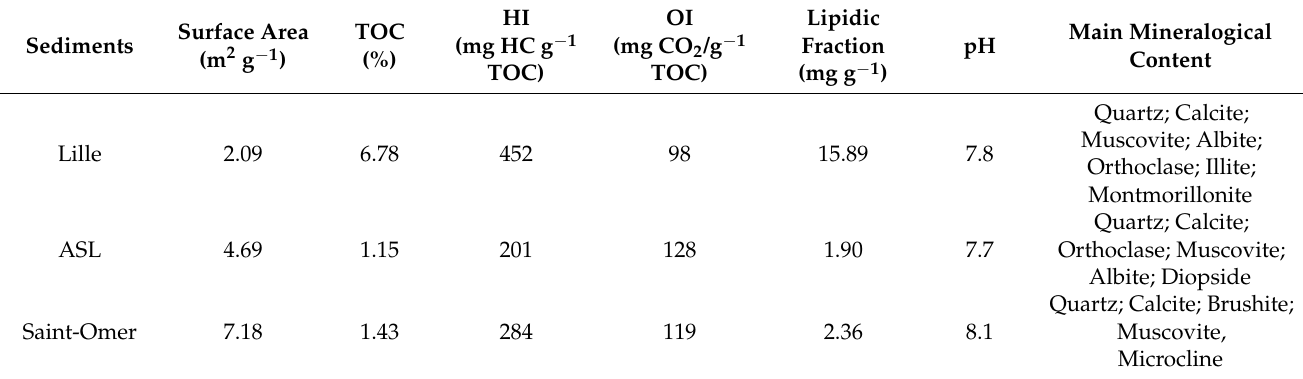
Table 1. Sediments mineralogical composition, surface area, Total Organic Carbon (TOC) content, Hydrogen Index (HI) and Oxygen Index (OI) measured before Zn spiking and interactions with the two stabilizers.